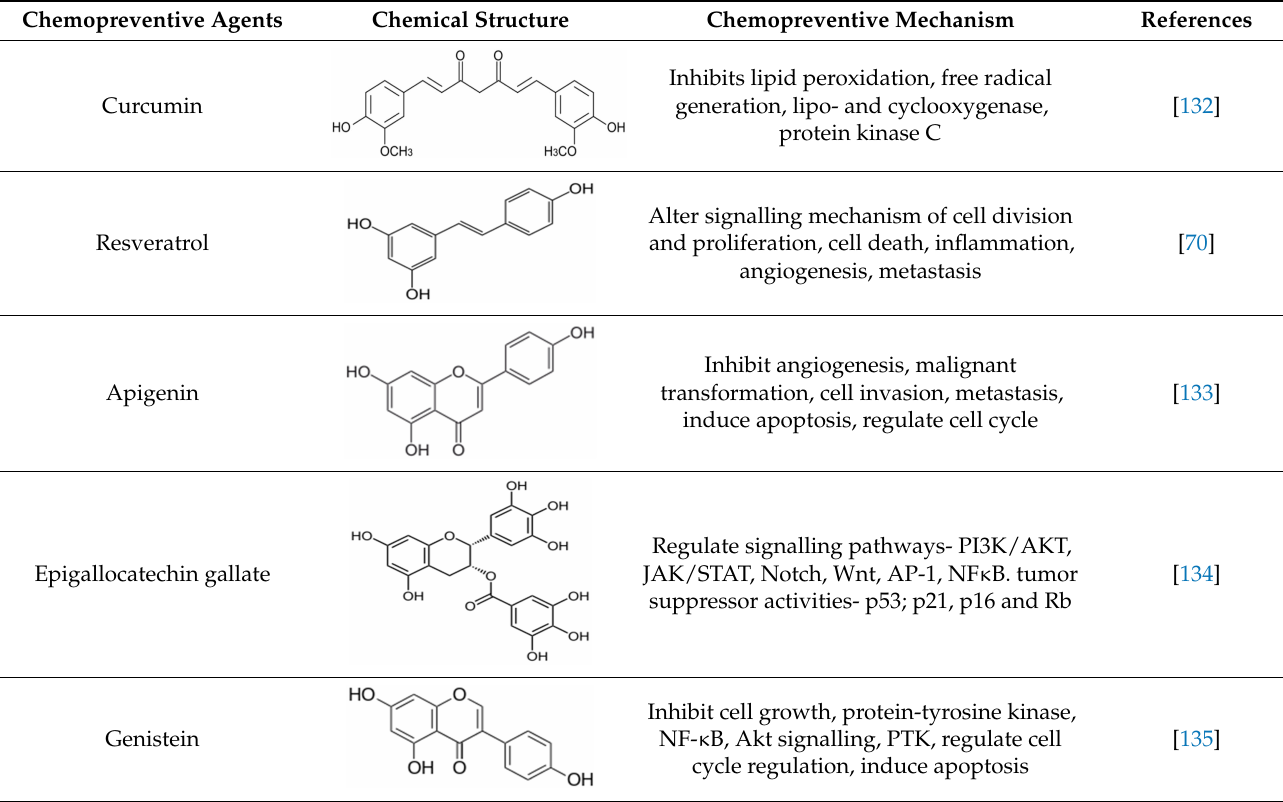
Table 2. Chemopreventive agents and